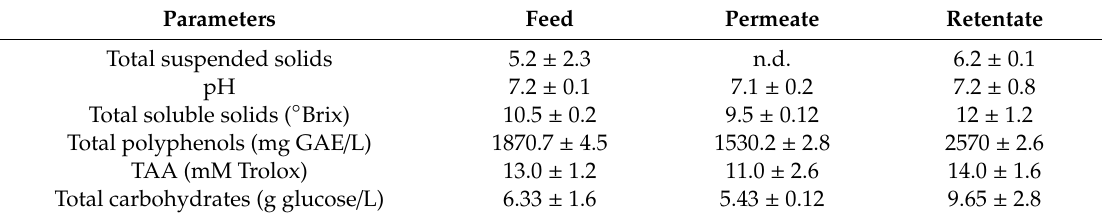
Table 2. Chemical composition of aqueous extract before and after the UF process.